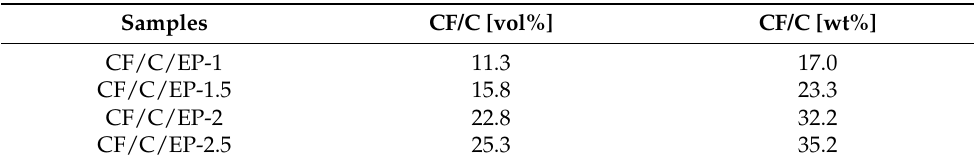
Table 1. The loading of the CF/C in the various CF